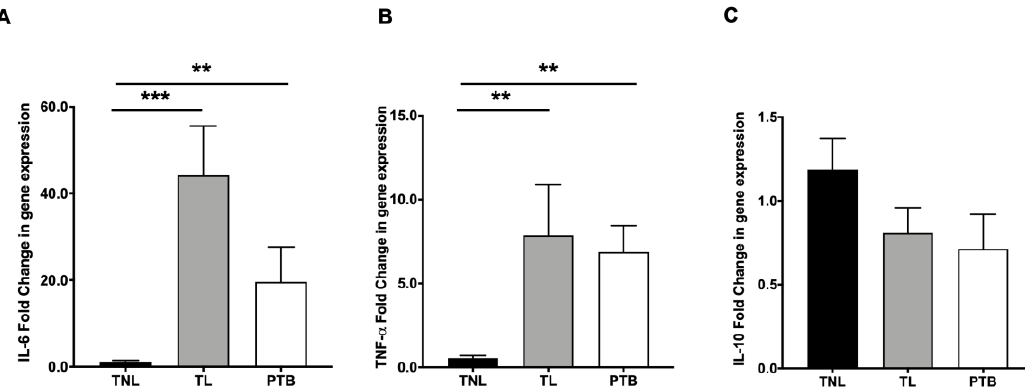
Figure 2. Levels of proinflammatory cytokines in human fetal membranes. Fetal membrane tissues from TNIL, TL, and PTB were analyzed for gene expression levels of ( A , B ) proinflammatory cytokines, such as interleukin (IL)-6 and IL-8, and ( C ) anti-inflammatory cytokine IL-10 levels. Data is shown as mean fold change ± SEM with a total of 8–12 samples per cohort. Statistical significance was determined by one-way ANOVA. *** p ≤ 0.001 and ** p ≤ 0.01 vs. TNIL.